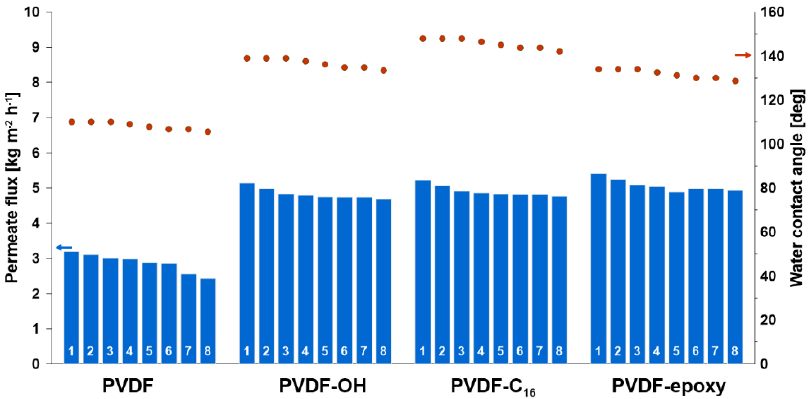
Figure 7. Membrane stability in desalination process—transport and material properties.